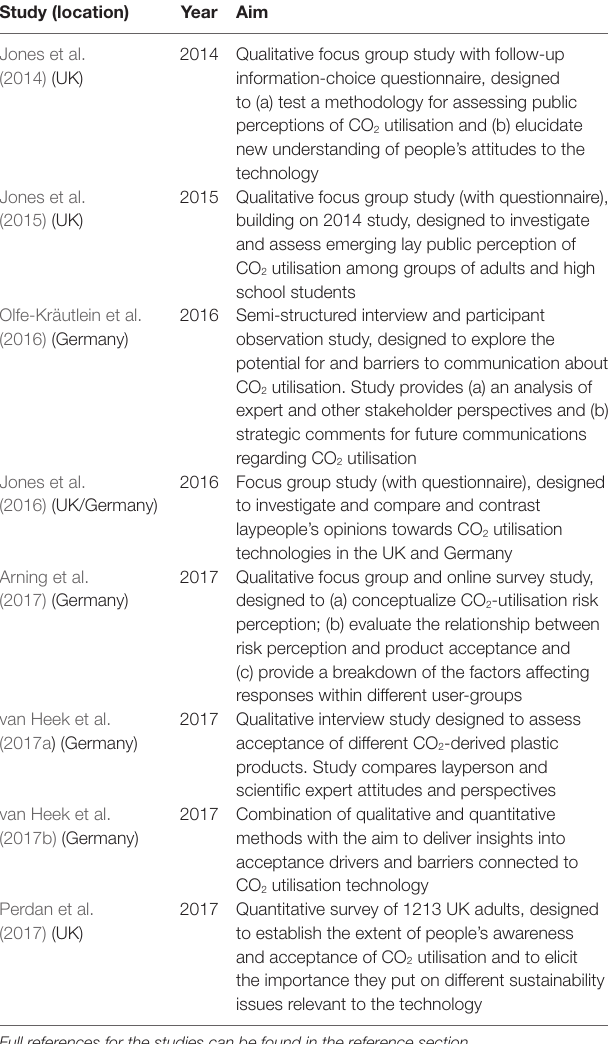
TAbLe 1 | Summary of the key studies conducted into emerging perceptions of CO 2 utilisation technologies and product